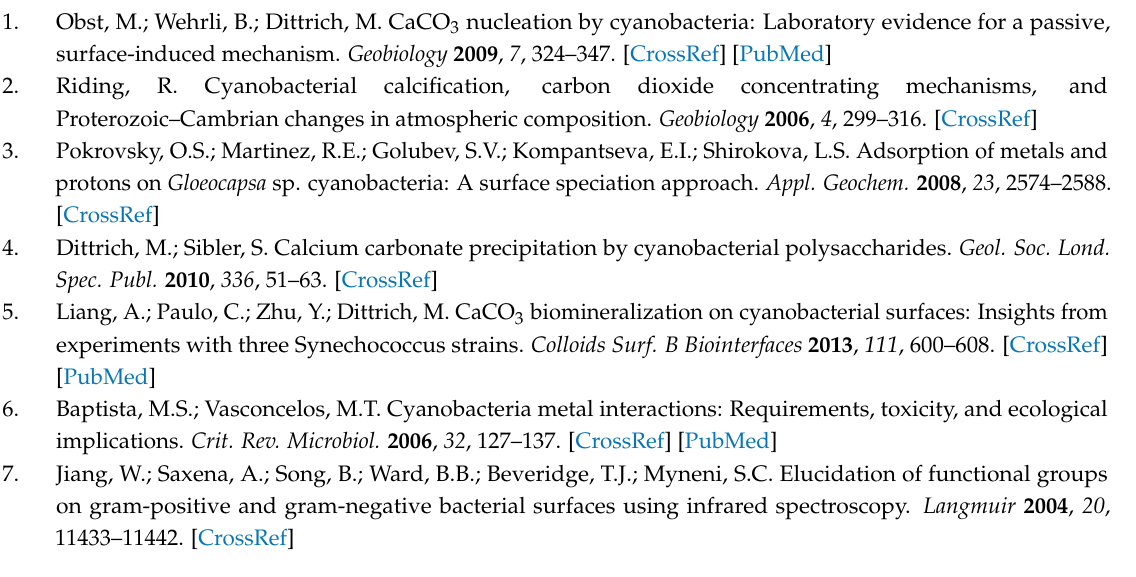
(confidence interval (R2) of 0.99). Table S2: ANOVA analysis of the thickness of cell surfaces under different P conditions. Table S3: ANOVA analysis of the Ca variation in precipitation experiments. Figure S1: Calibration curves of Synechococcus sp. optical densities to cell enumeration by image-analyzed epifluorescence microscope. Figure S2: Growth curves of Syn. PCC8806 under constant light. Each data point was obtained from the average of five replicates. Figure S3: Example of the transmission electron microscopy (TEM) micrographs of single cells, the single used for thickness measurements. The red arrows indicate the cell membrane structure in the zoomed areas. Figure S4: Variation of (a) the growth-rate constant (d-1), (b) the C/A ratio, and (c) the average thickness of Syn. PCC8806 under different P concentrations. Figure S5: The results of the potentiometric titrations. The circles plots represent the average of three potentiometric titrations for each strain and P condition. Fitted charge excess (see Equation (1) in the main text) obtained through LPM is represented by lines (dashed and continuous) with the same color as the corresponding P conditions. Figure S6: High resolution (0.1 eV step-size) XPS spectra of Synechococcus PCC8806 deconvoluted to C1s, O1s, and N1s peaks to determine their chemistry. Figure S7: (a) Dynamics of pH in abiotic conditions (control) and in the presence of Syn. PCC8806 biomasses. Data collected after 7 and 24 h. (b–d) Dynamics of dissolved calcium at different stages of the experiment. The initial Ca concentration was 2.52 mM. Figure S8: Ca removal rates and N content of cell surface (a) and surface functional groups (b). Figure S9: Principal components (PC1 vs. PC2) score plots (a) and loading plots (b) of the FTIR spectra of Syn. PCC8806 obtained at different pH (indicated in the figure). Figure S10: SEM micrographs of the precipitates (a–c) formed in the presence of cells of Syn. PCC8806 cultured at 90 µ M P. Figure S11: The SEM images and respective EDX spectra obtained from the precipitates in the biomineralization experiments: (a,b) With PCC8806 (40 µ M), (c,d) with Syn. PCC8806 (90 µ M), (e,f) with Syn. PCC8806 (180 µ